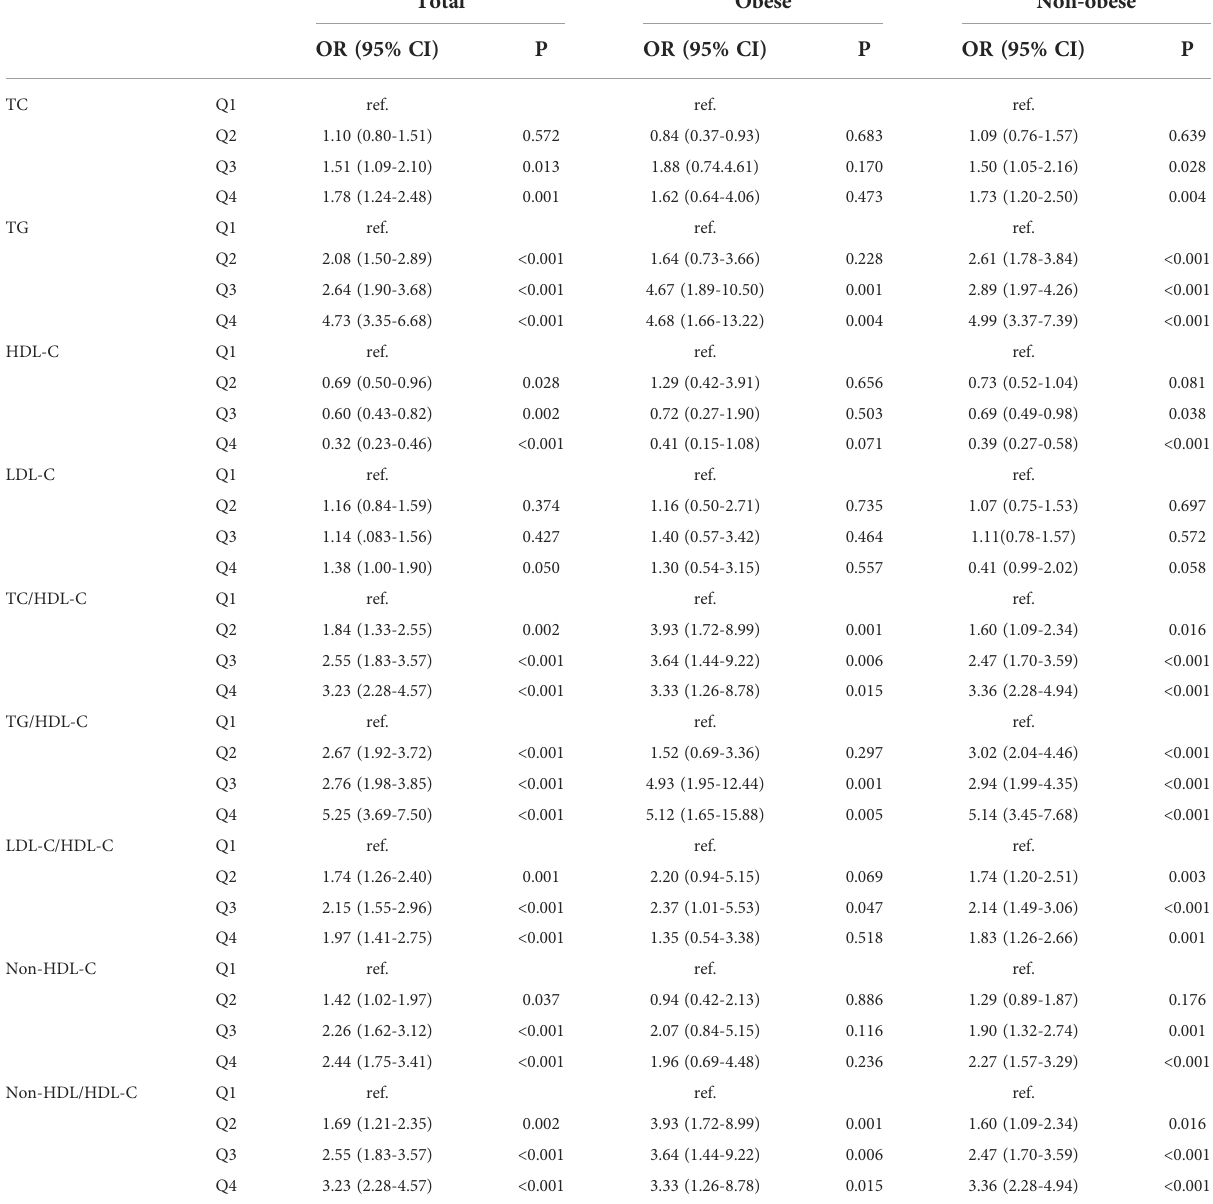
TABLE 3 Odds raitos and 95% con fi dence intervals of lipid parameters in terms of the quartiles for non-alcoholic fatty liver disease according to obesity status. Total Obese